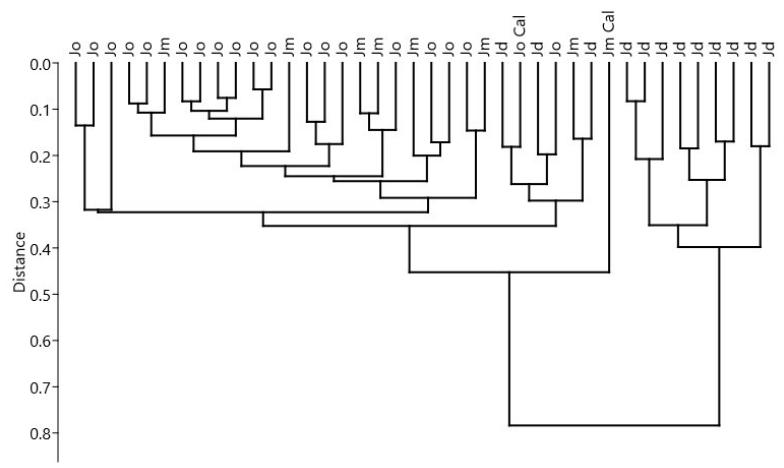
Figure 3. Dendrogram of cluster analysis of essential oils of J. oxycedrus (Jo), J. macrocarpa (Jm), and J. deltoides (Jd). “Cal” represents our samples.